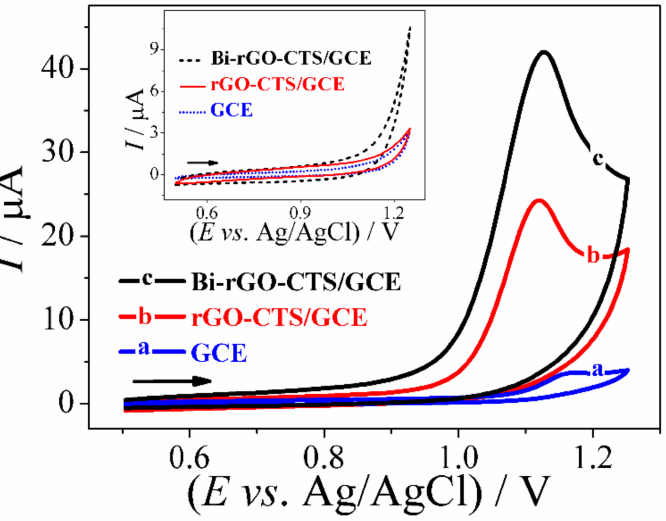
Figure 3. Electrochemical profiles of GCE, rGO-CTS/GCE and Bi-rGO-CTS/GCE. Analysis conditions-electrolyte solution: 0.04 mol L − 1 Britton-Robinson buffer solution (pH 4); scan rate ( ν ): 50 mV s − 1 ; 3-methylmorphine concentration: 0.10 mmol L − 1 . Inset: without the addition of